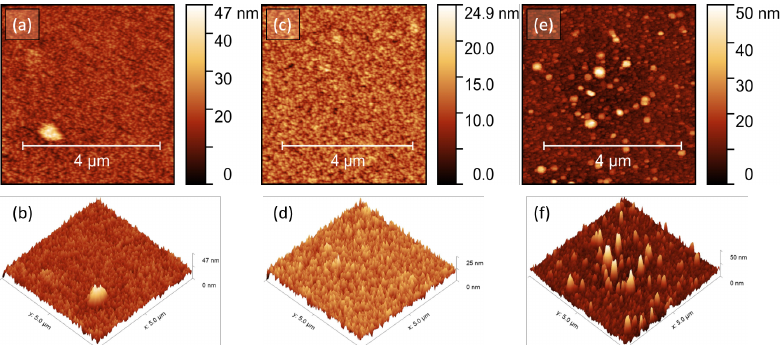
Figure 4. Atomic Force Microscope (AFM) top-view ( a , c , e ) and corresponding three-dimensional (3D) surface profile ( b , d , e ) of the CdTe films surfaces deposited by VTE ( a , b ) and RF-MS ( c , d ) on a pristine optical glass substrate and by ECD ( e , f ) on an Si substrate previously coated by a thin Au layer. Table 1. Morphological parameters of the CdTe thin films deposited by VTE, RF-MS, and ECD, as statistically evaluated by AFM analysis. RMS represents the route mean square roughness and Ssk and K are the corresponding Skewness and Excess Kurtosis coefficients, respectively. The thickness of the deposited CdTe films (h) is indicated (SE denotes the standard error) as well, being directly estimated by SEM for all samples and subsequently calculated from the optical transmission spectra only for the VTE- and RF-MS-deposited CdTe thin films, respectively (see Section 3.3). Deposition